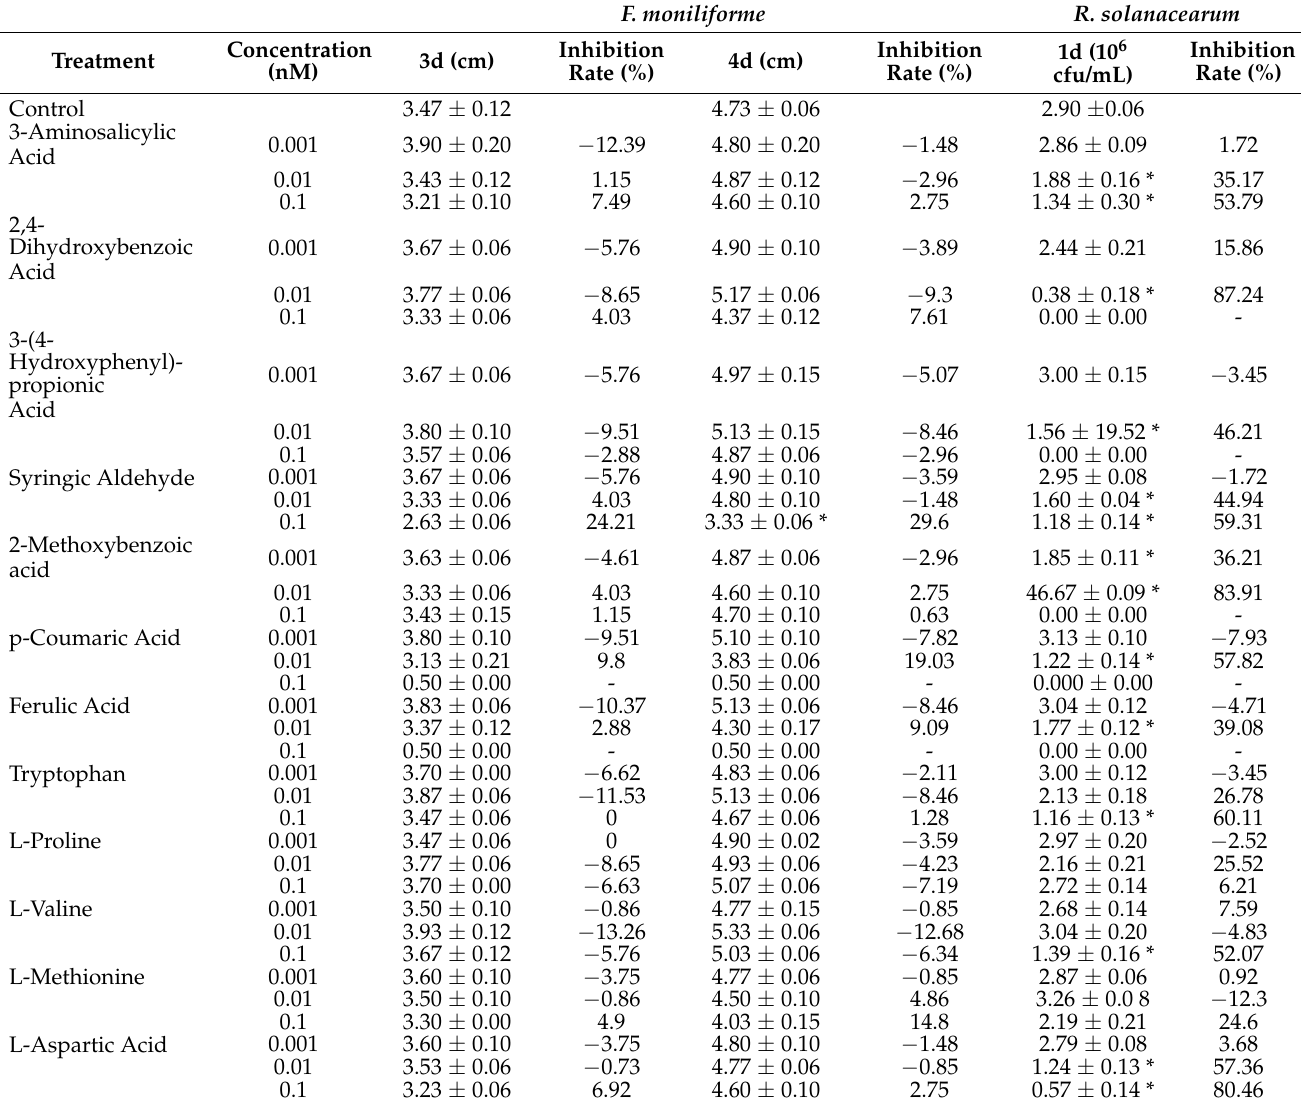
Table 2. Effects of exogenous phenolic acids and amino acids on growth of R. solanacearum and F. moniliforme